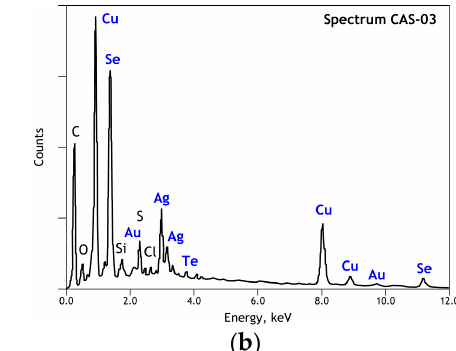
Figure 1. SEM-EDS results of initial copper anode slime: ( a ) General view (backscattered electron micrograph) of the used sample; ( b ) Overall EDS analysis of the used sample.